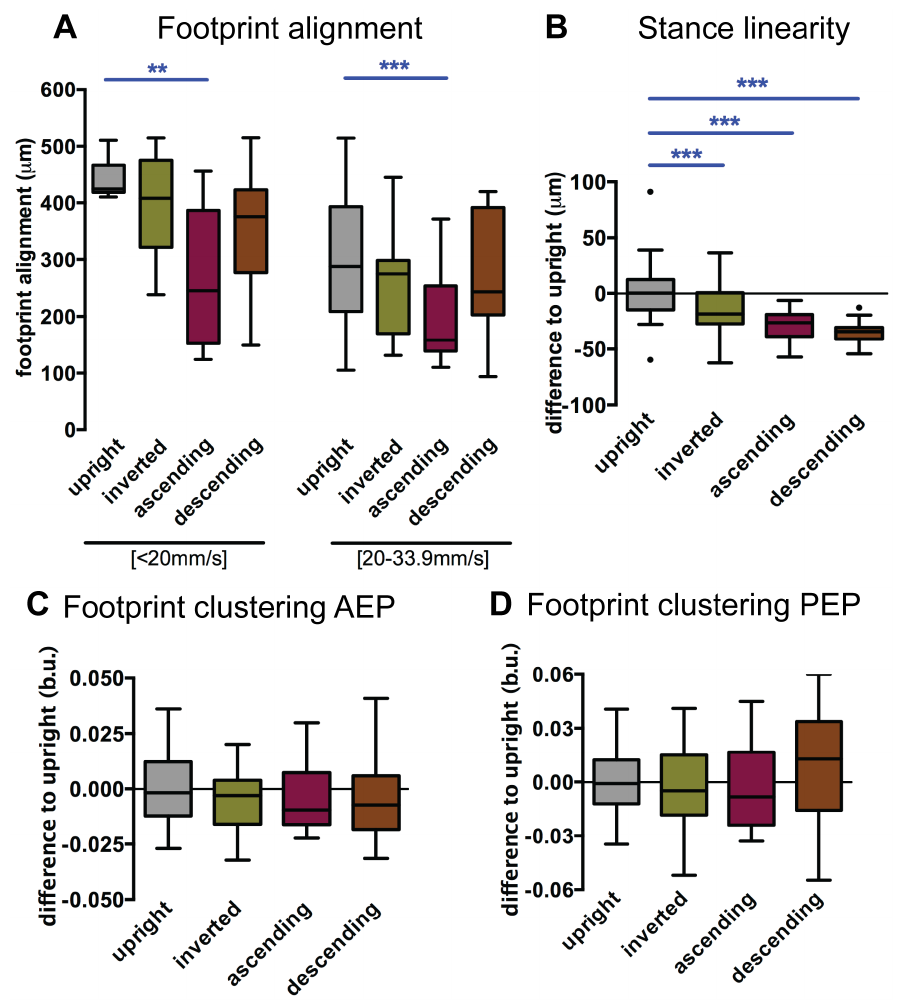
Figure 2. Spatial parameters. Non-upright walking animals display more aligned footprints and less jitter during stance phases, while clustering remains unchanged. (A–D) Boxplots represent the median as the middle line, with the lower and upper edges of the boxes representing the 25% and 75% quartiles, respectively; the whiskers represent the range of the full data set, excluding outliers. Circles indicate outliers. Statistical analysis with one-way ANOVA followed by Tukey’s post hoc test, * P , 0.05; ** P , 0.01; *** P , 0.001. Statistically significant decreases are indicated in blue. In B, C and D data was residual normalized and expressed as the difference to the upright control. (A) Ascending animals show more aligned footprints. Data were grouped into slow ( , 20 mm/s) and medium (between 20 and 34 mm/s) speeds. (B). Non-upright animals display lower values for stance linearity indicating lower jitter during stance phases. (C–D) Footprint clustering remains unchained for Anterior Extreme Position (AEP) and Posterior Extreme Position (AEP). (b.u., body